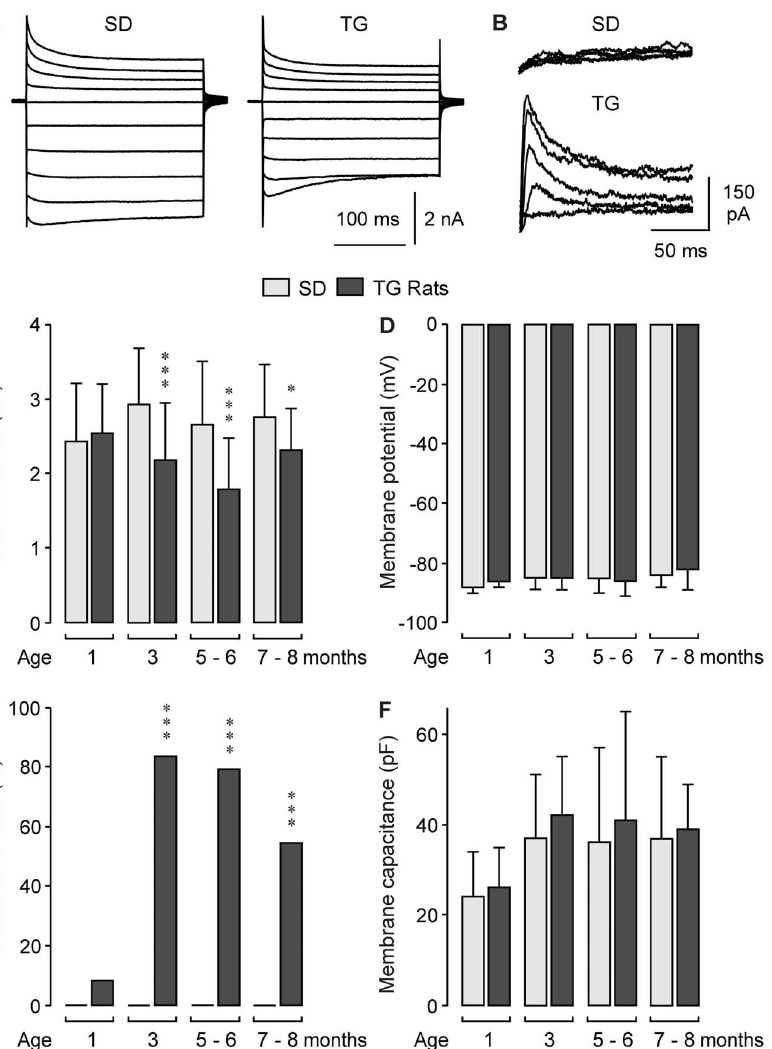
Figure 7. Age-dependent alterations in the membrane characteristics of isolated Mu¨ller glial cells. The cells were obtained from control (SD) and transgenic (TG) rats. A. Representative potassium current traces of cells from 3-months animals. The potassium currents were evoked by 20- mV incremental voltage steps between 2 180 and 0 mV from a holding potential of 2 80 mV. Outward currents evoked by depolarizing voltage steps are depicted upwardly ; inward currents evoked by hyperpolarizing voltage steps are depicted downwardly . B. Representative current traces which were obtained with the difference protocol to isolate fast transient (A-type) potassium currents described in the Materials and Methods section. The cell isolated from a retina of a 3-months SD rat displayed no A-type currents while such currents were present in the cell obtained from a 3-months TG rat. C. Mean amplitude of the inward potassium currents of Mu¨ller cells (measured at the voltage step from 2 80 to 2 140 mV) in dependence on the age of the animals. D. Resting membrane potential. E. Incidence of cells that displayed A-type potassium currents in response to depolarizing voltage steps. F. Cell membrane capacitance. Each bar represents values obtained in 16–45 cells from 3–7 animals. Significant difference between data from TG and and age-matched SD rats: * P =0.05; *** P ,